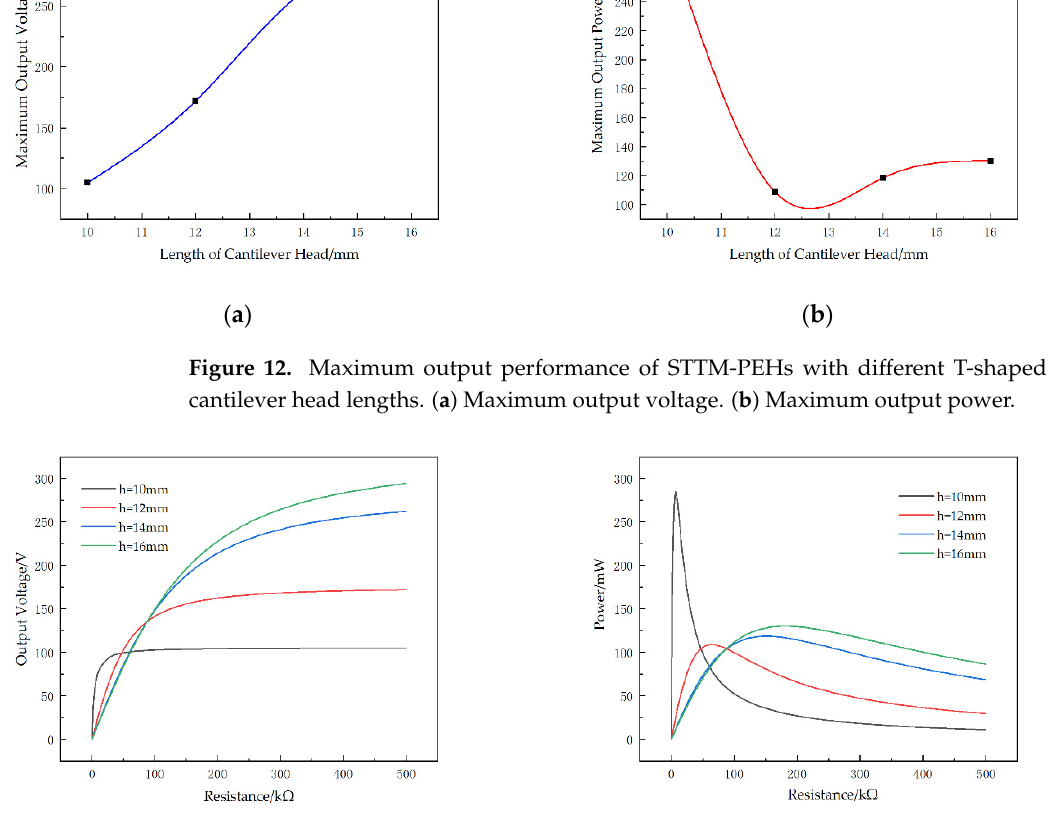
Figure 12. Maximum output performance of STTM-PEHs with different T-shaped trapezoidal can- tilever head lengths. ( a ) Maximum output voltage. ( b ) Maximum output power.